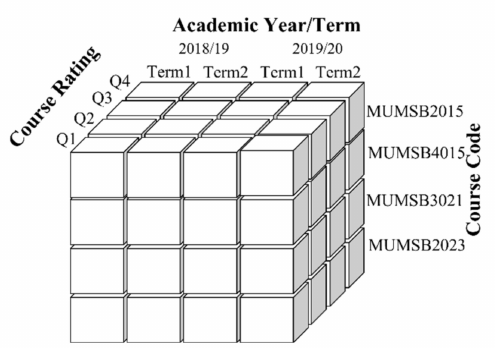
Figure 3. A multi-dimensional data model (3D data cube) for the course